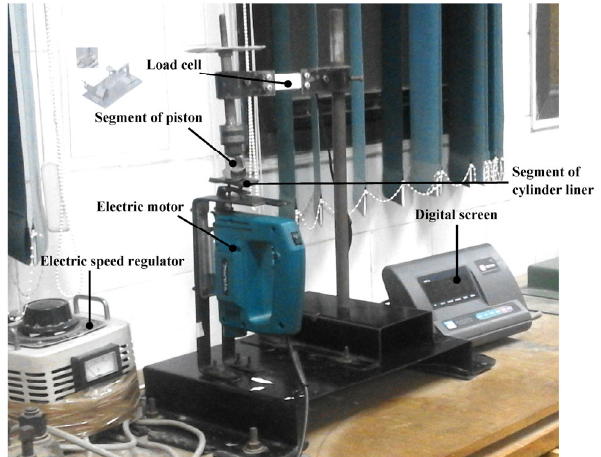
Fig. 2 Configuration of test